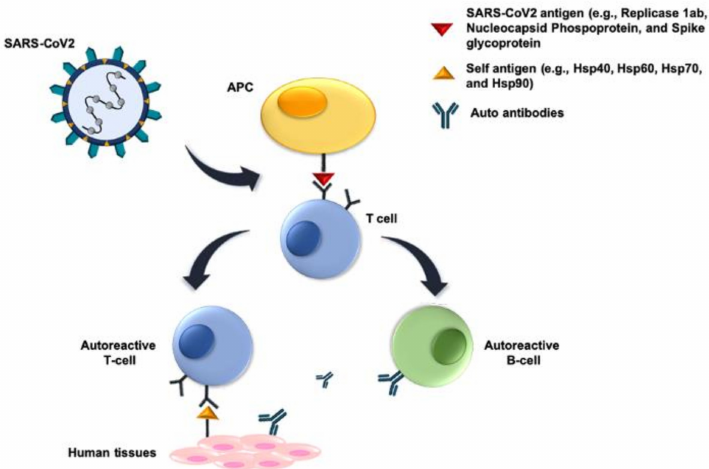
Figure 2. Molecular mimicry mechanisms. Molecular mimicry of host proteins by viral proteins means that there are cross-reacting antigenic epitopes shared between SARS-Cov-2 and host proteins (e.g., molecular chaperones), which induce humoral and cellular immunological reactivity against the host. The SARS-Cov-2 antigens involved probably occur in peptides of Replicase 1ab, Nucleocapsid Phosphoprotein, and Spike glycoprotein, and they induce B and / or T cells. The former cells produce antibodies reacting against the virus and also against the host crossreactive antigens. Similarly, the induced T cells react with host tissues. In both instances, autoimmunity occurs, damaging host’s tissues and organs. Abbreviation: APC, antigen-presenting